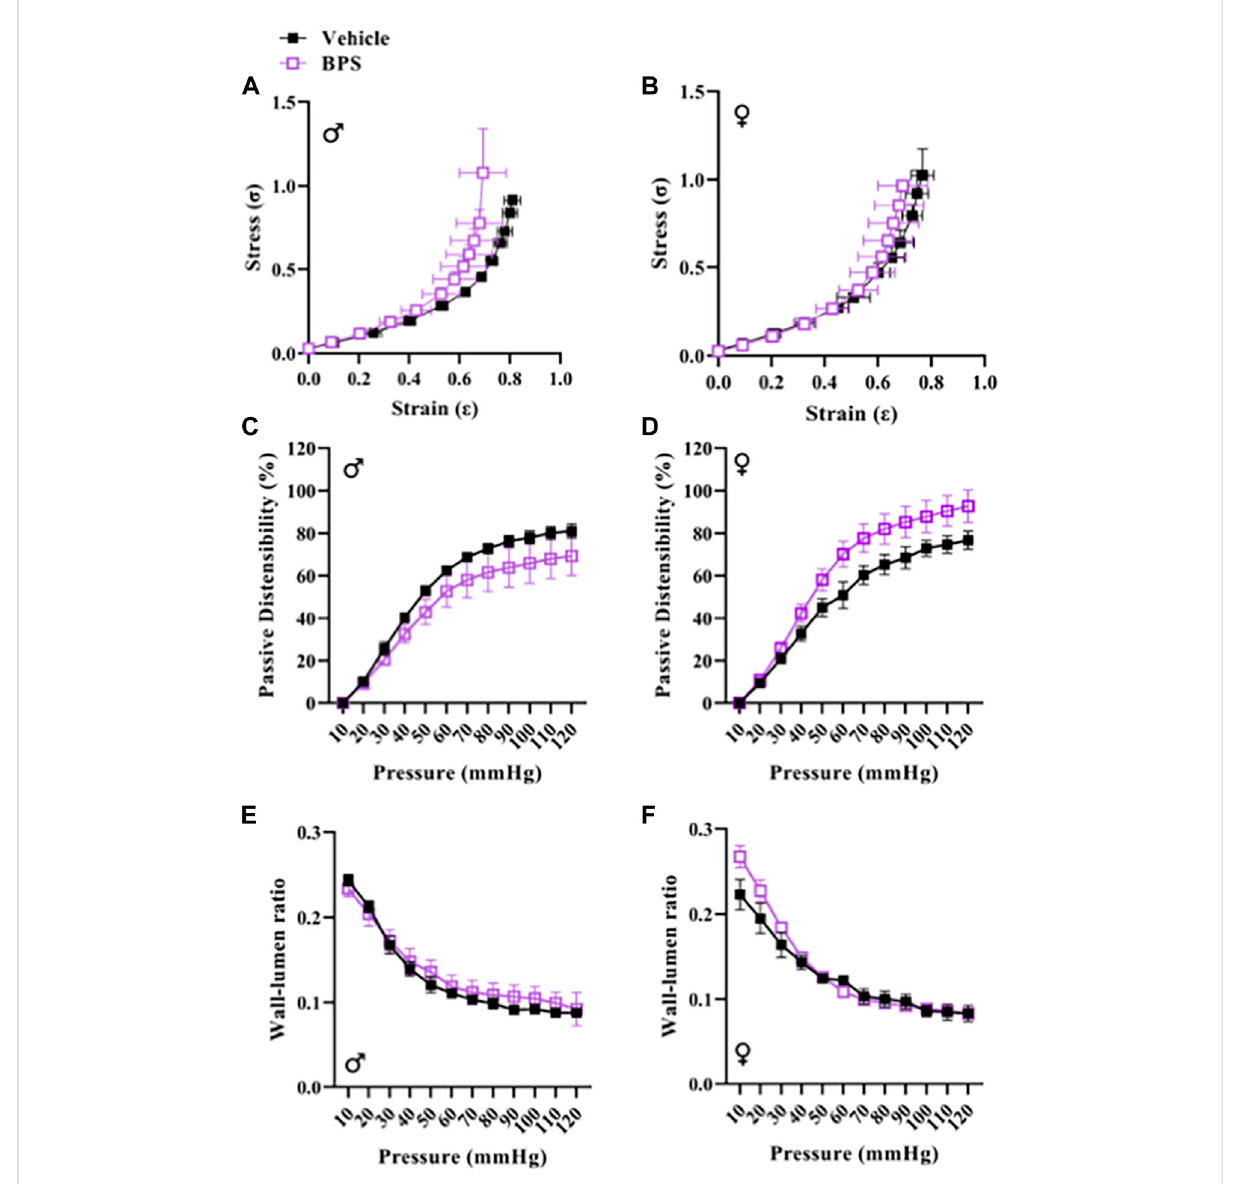
FIGURE 3 BPS exposure has no impact on passive mechanical function of mesenteric arteries. The stress-strain relationship of 4th order mesenteric arteriesisolatedfrom (A) male( n =5control; n =5BPS)or (B) female( n =5control; n